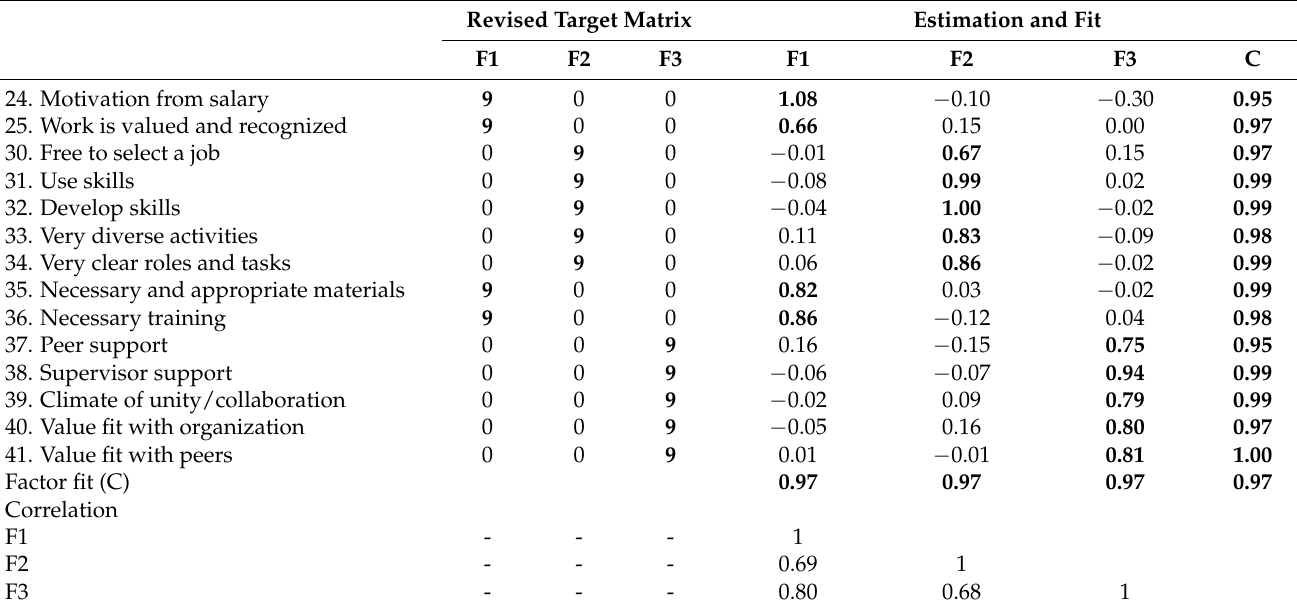
Table 7. Positive psychosocial resource factors: final iteration (n =